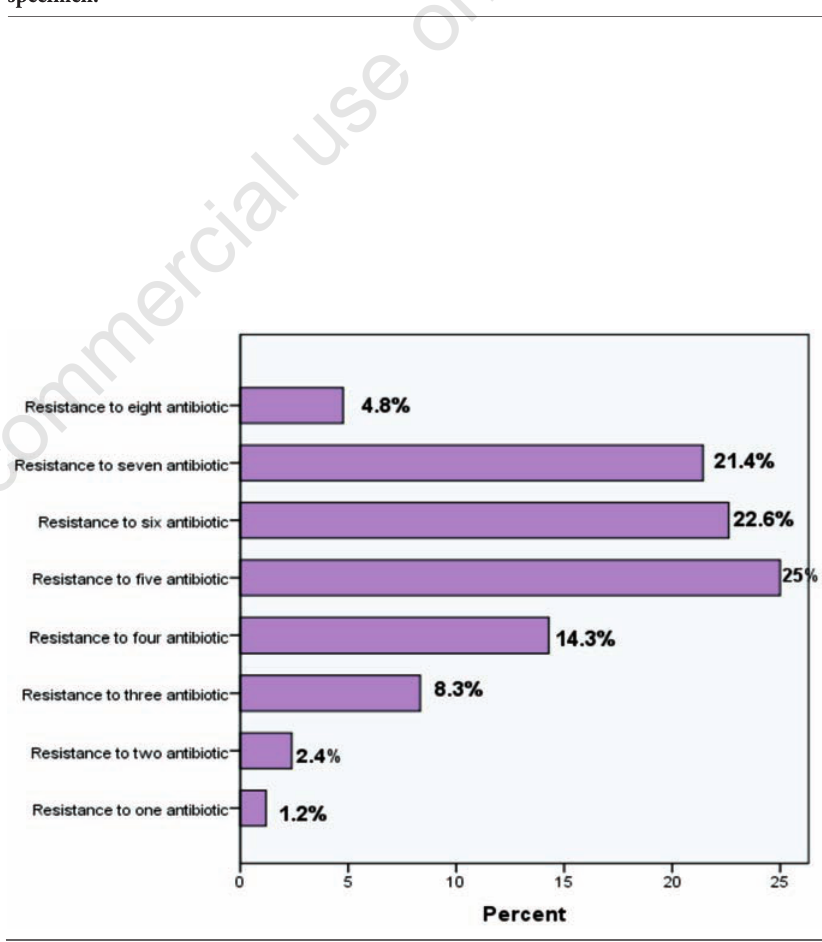
Figure 2. Multidrug resistance of methicillin-resistant Staphylococcus aureus . Multi drug resistance of methicillin-resistant Staphylococcus aureus . Generally, out of the 84 MRSA isolates, 25% were resistant to more than five antibiotics used, followed by 22.6%, 21.4%, 14.3%, 8.3% and 4.8% for six antibiotics, seven antibiotics, four antibiotics, three antibi- otics and eight antibiotics respectively. Also 2.4% of MRSA were resistant to two antibi- otics. Whiles 1.3% were resistant to one antibiotic. In general 96.3% of the isolates were resistant to three or more